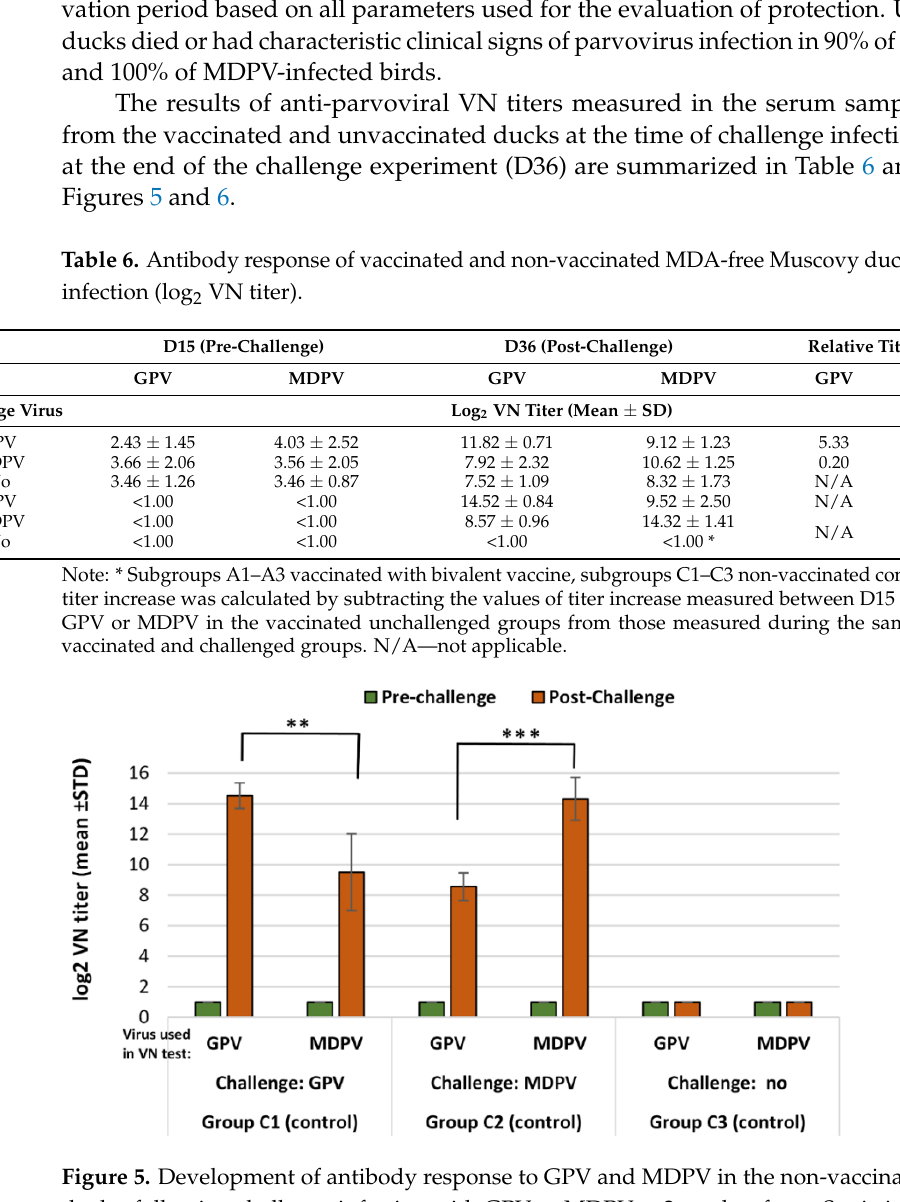
Table 6. Antibody response of vaccinated and non ‐ vaccinated MDA ‐ free Muscovy ducks to chal ‐ lenge infection (log 2 VN titer).